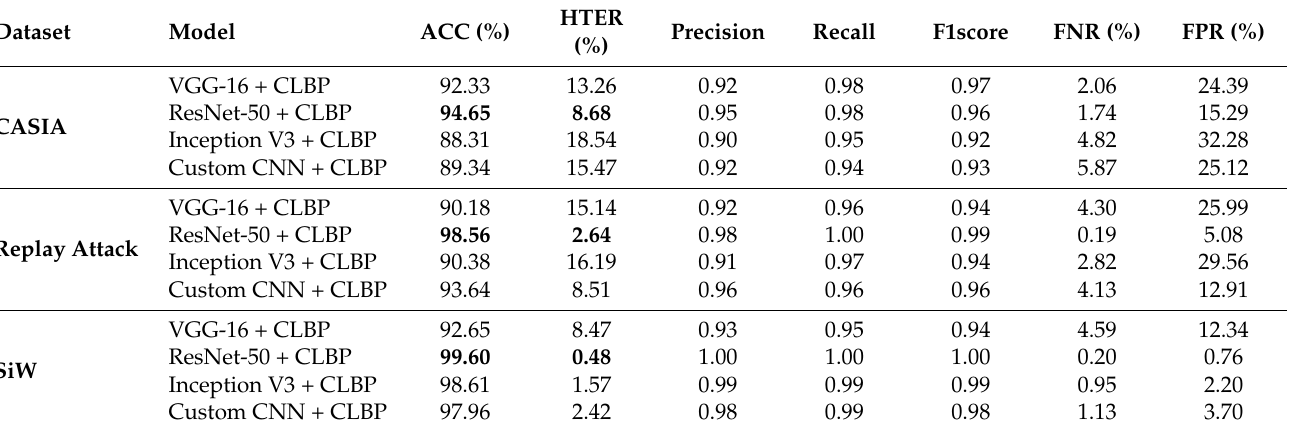
Table 4. Fusion methods